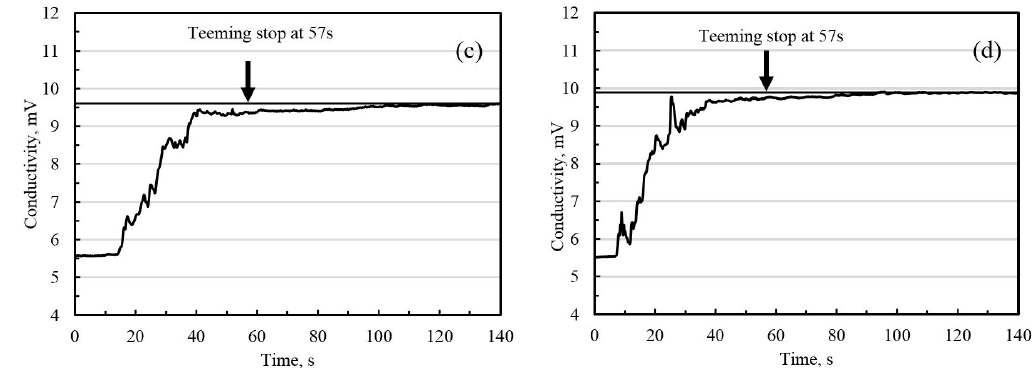
Figure 11. Measurement differences of the tracer at a bath depth of 500 mm; ( a ) Q = 0, ( b ) Q = 0.025, ( c ) Q = 0.045, ( d ) Q = 0.065.